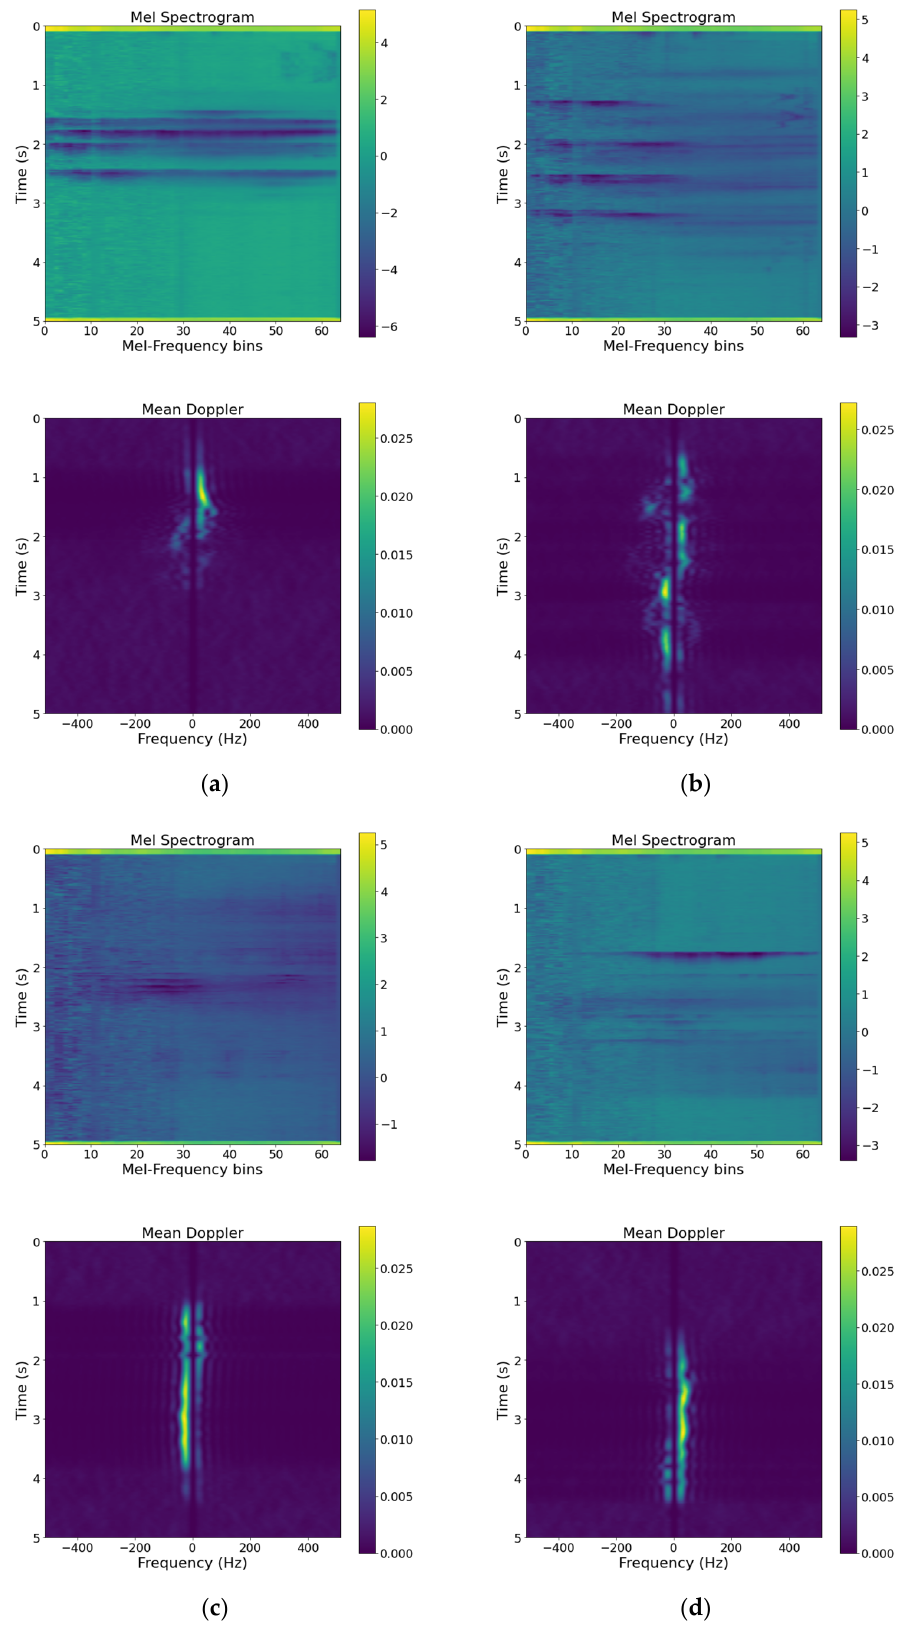
Figure 3. Extracted Doppler and Mel-spectrogram features from recorded data of 4 activities: ( a ) falling activity; ( b ) walking activity; ( c ) sitting activity; ( d ) standing up